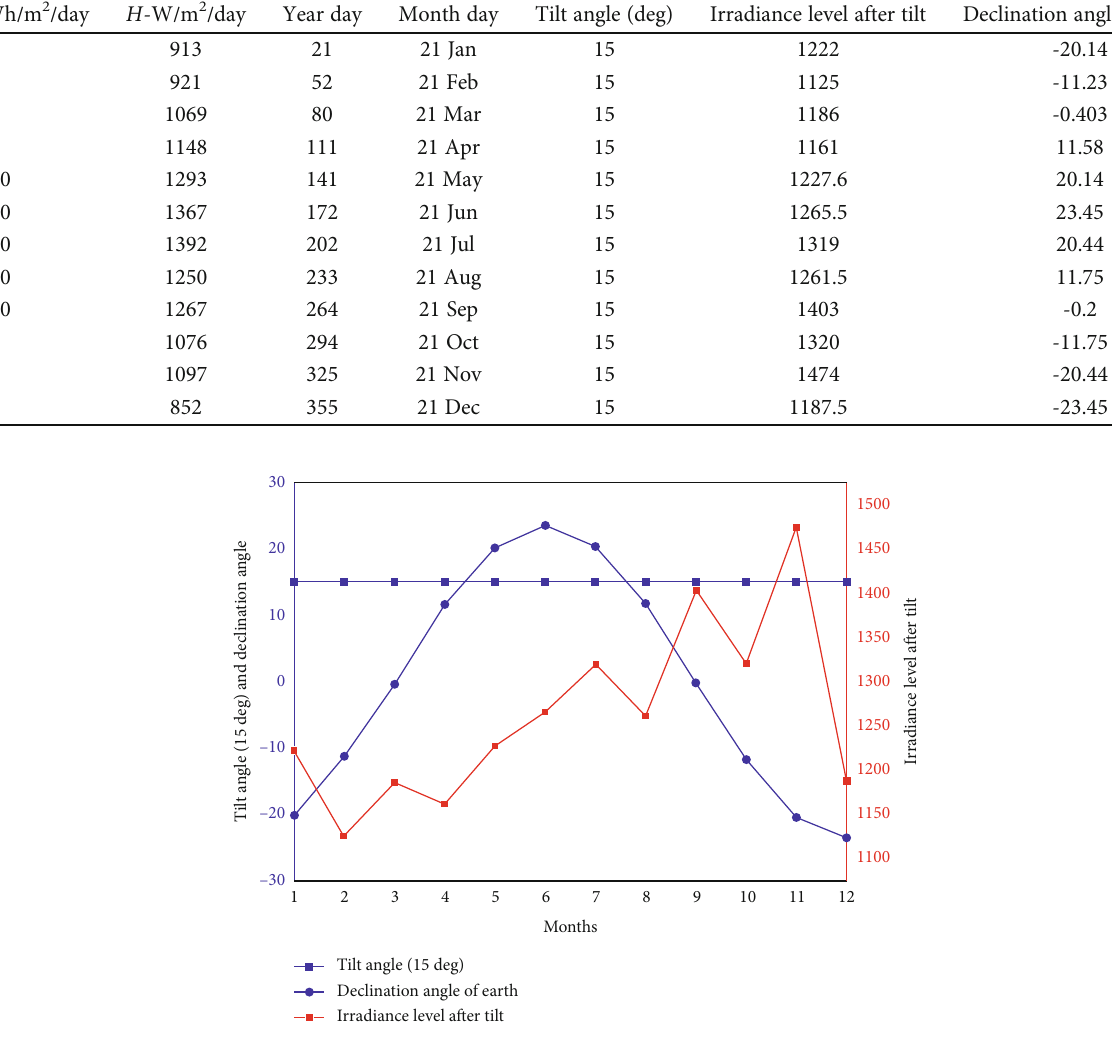
Figure 2: Speci fi c monthly irradiance on fi xed tilt angle (15 deg) and declination angle vs.